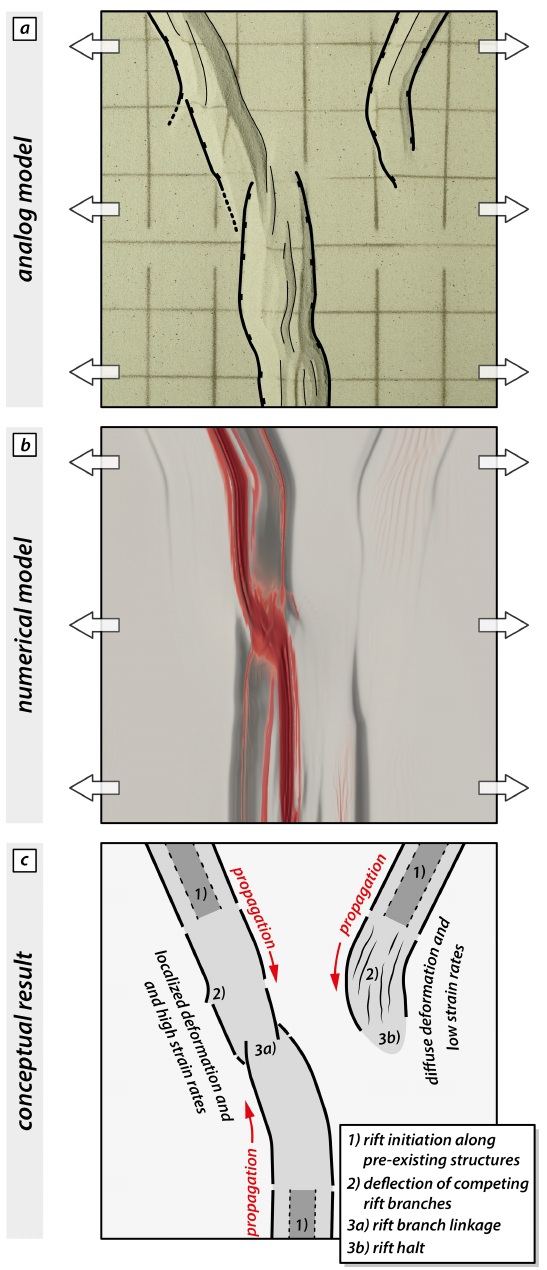
Figure 9. Summary plot showing the geometric similarity of rift segment linkage, deflection of competing branches, and abandon- ment in analog and numerical models. (a) Observed key features at the final stage of the analog model. (b) Final strain and strain rate pattern in the numerical reference model. (c) Conceptual interpreta- tion of rift deflection and linkage based on our analog and numerical results (for details see